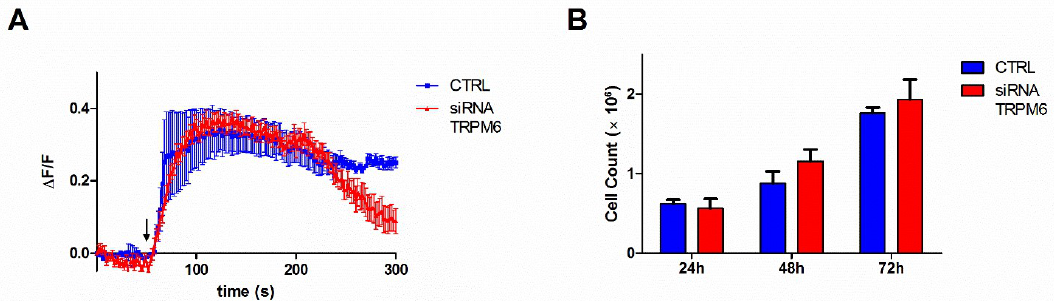
Figure 4. Contribution of TRPM6 to Mg 2+ influx and cell proliferation in colon cells. HT29 cells were transiently silenced for TRPM6 and assessed at the indicate times after transfection. ( A ) Mg 2+ influx capacity, as assessed 72 h after siRNA transfection. Mag-Fluo-4-loaded cells were challenged with 20 mM Mg (arrow) and time course of single-cell fluorescence was followed by live confocal imaging. The mean fluorescence ( ∆ F/F) of 10 cells ± SE from a representative experiment is reported ( n = 3). ( B ) Cell proliferation. Cells were counted in duplicates; mean ± SE of three independent experiments is shown.